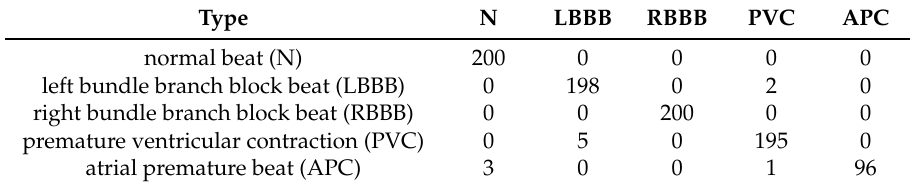
Table 2. Classification results of the support vector machine (SVM) classifier.